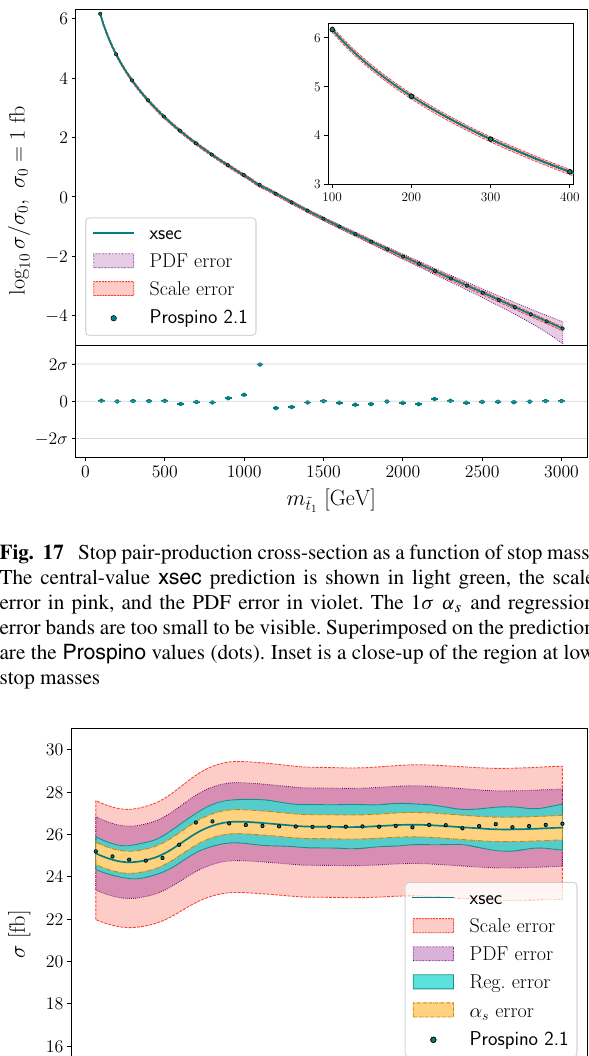
Fig. 18 Stoppair-productioncross-sectionasafunctionofgluinomass = 800GeV, with all other squark masses set to 1TeV. The for m ˜ t 1 central-value xsec predictionandthe1 σ regressionerrorbandisshown in light green, the scale error in pink, the PDF error in violet, and the α s error in yellow. Below we show the residual between the xsec and Prospino results